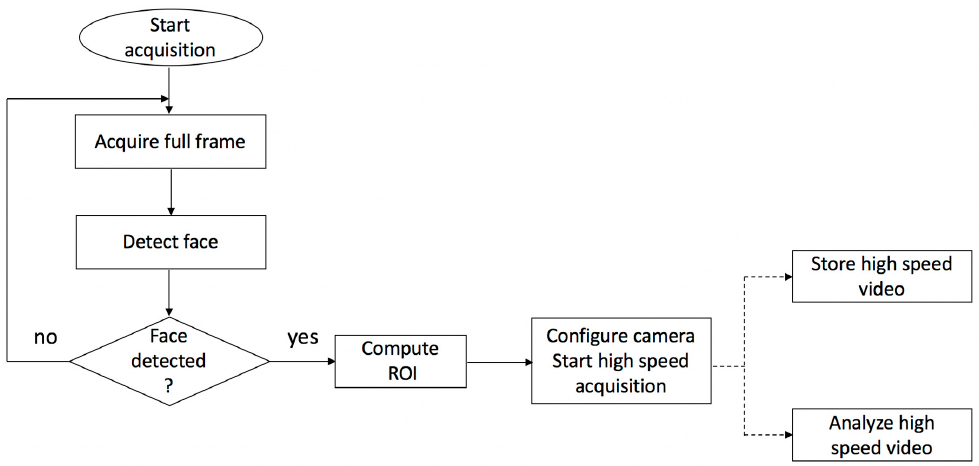
Figure 2. High-speed video acquisition and analysis process.